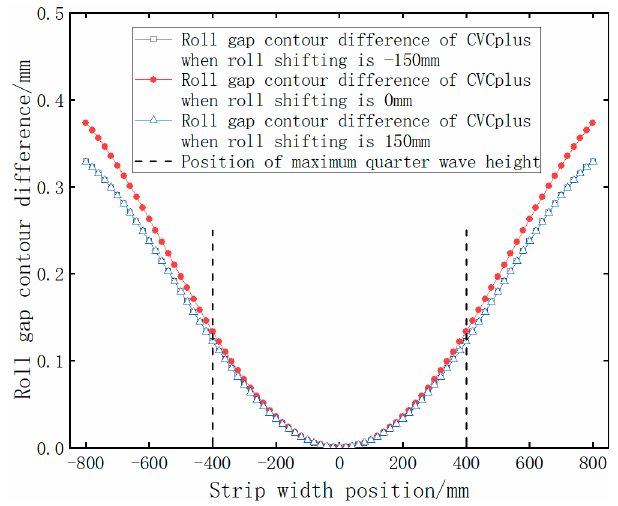
Figure 6. Roll gap contour difference between CVCplus and CVC.